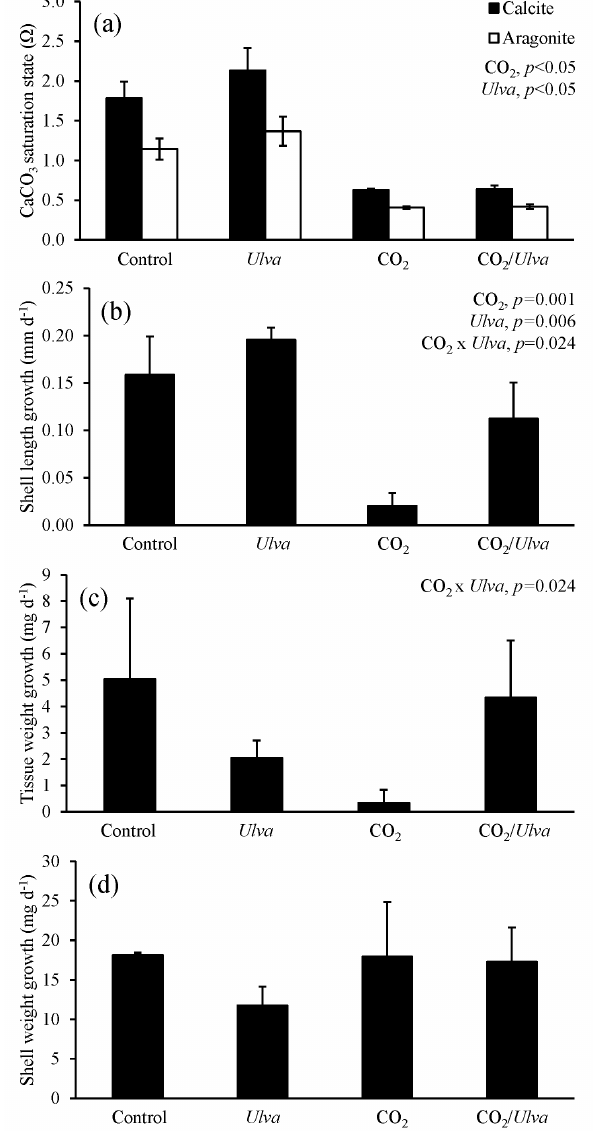
Figure 4. Experiment with large juvenile Crassostrea virginica ex- posed to ambient and elevated concentrations of CO 2 with and without the presence of Ulva . (a) (cid:127) calcite and (cid:127) aragonite ; growth was based on (b) shell length, (c) tissue weight, and (d) shell weight. Columns represent means ± standard deviation. Significant main treatment effects (CO 2 and Ulva ) appear at the top right of each